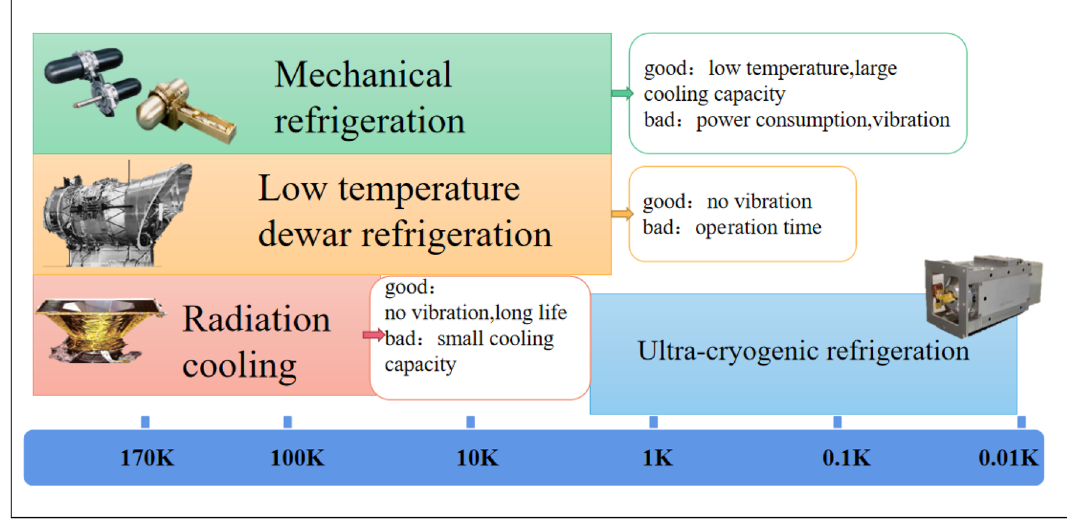
Figure 18. The main cryogenic technologies for space detection and its characteristics (generated by wps office 11.1.0.11115-releaase https:// www. wps. cn/).